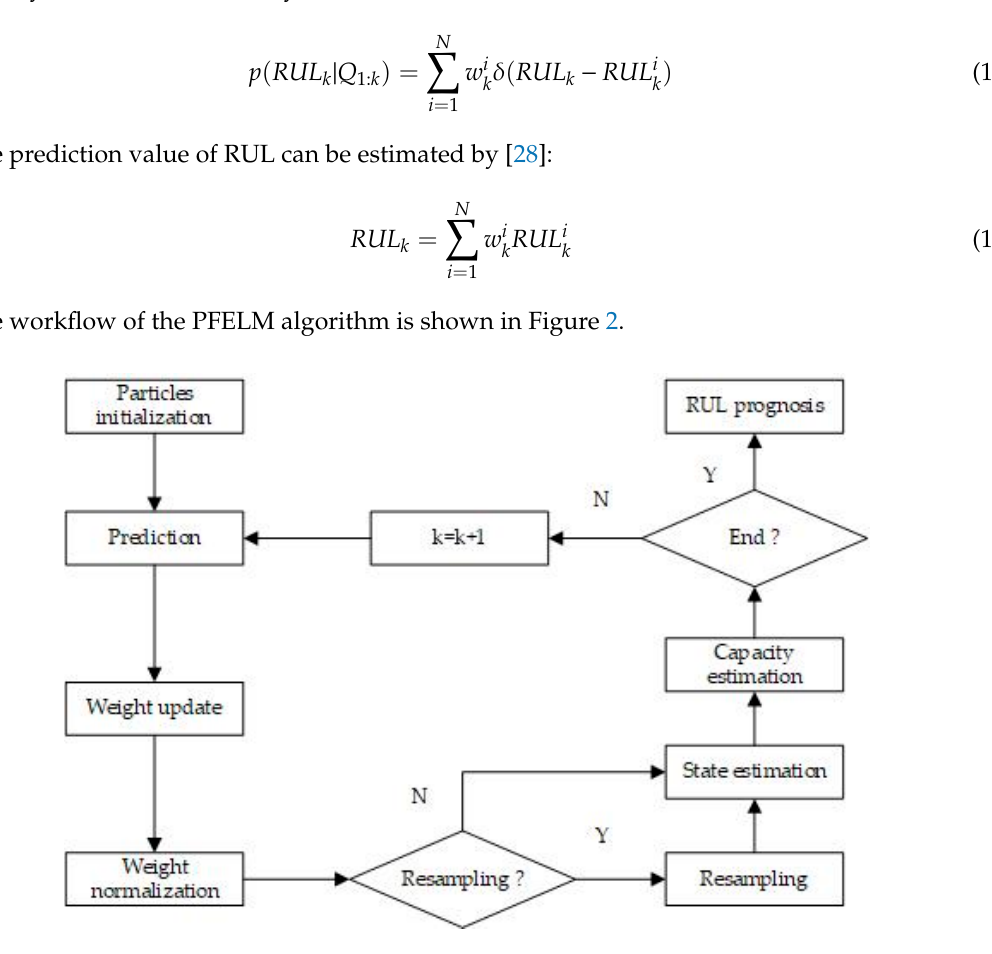
Figure 2. Prognosis process of the particle filter based extreme learning machine (PFELM)